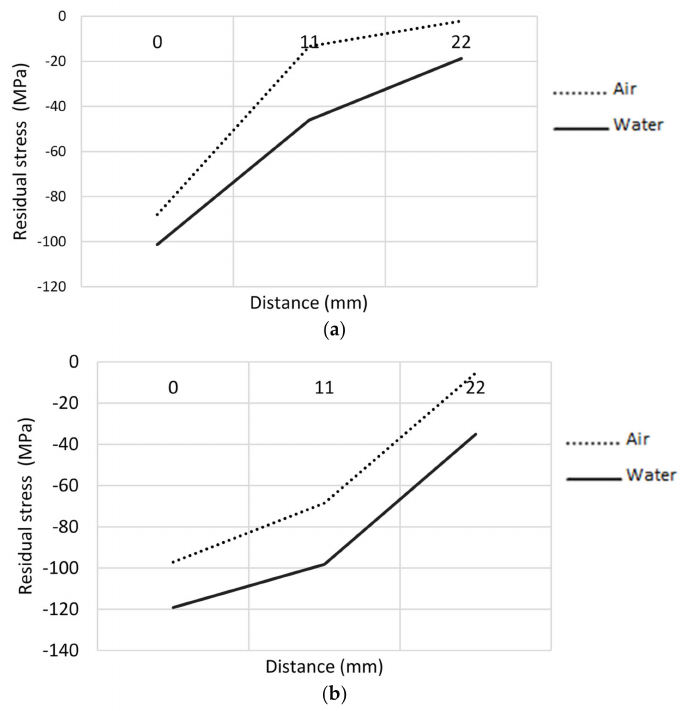
Figure 6. Residual stress obtained from the theoretical model MEF for a leg of ( a ) 3 mm, ( b ) 5 mm.